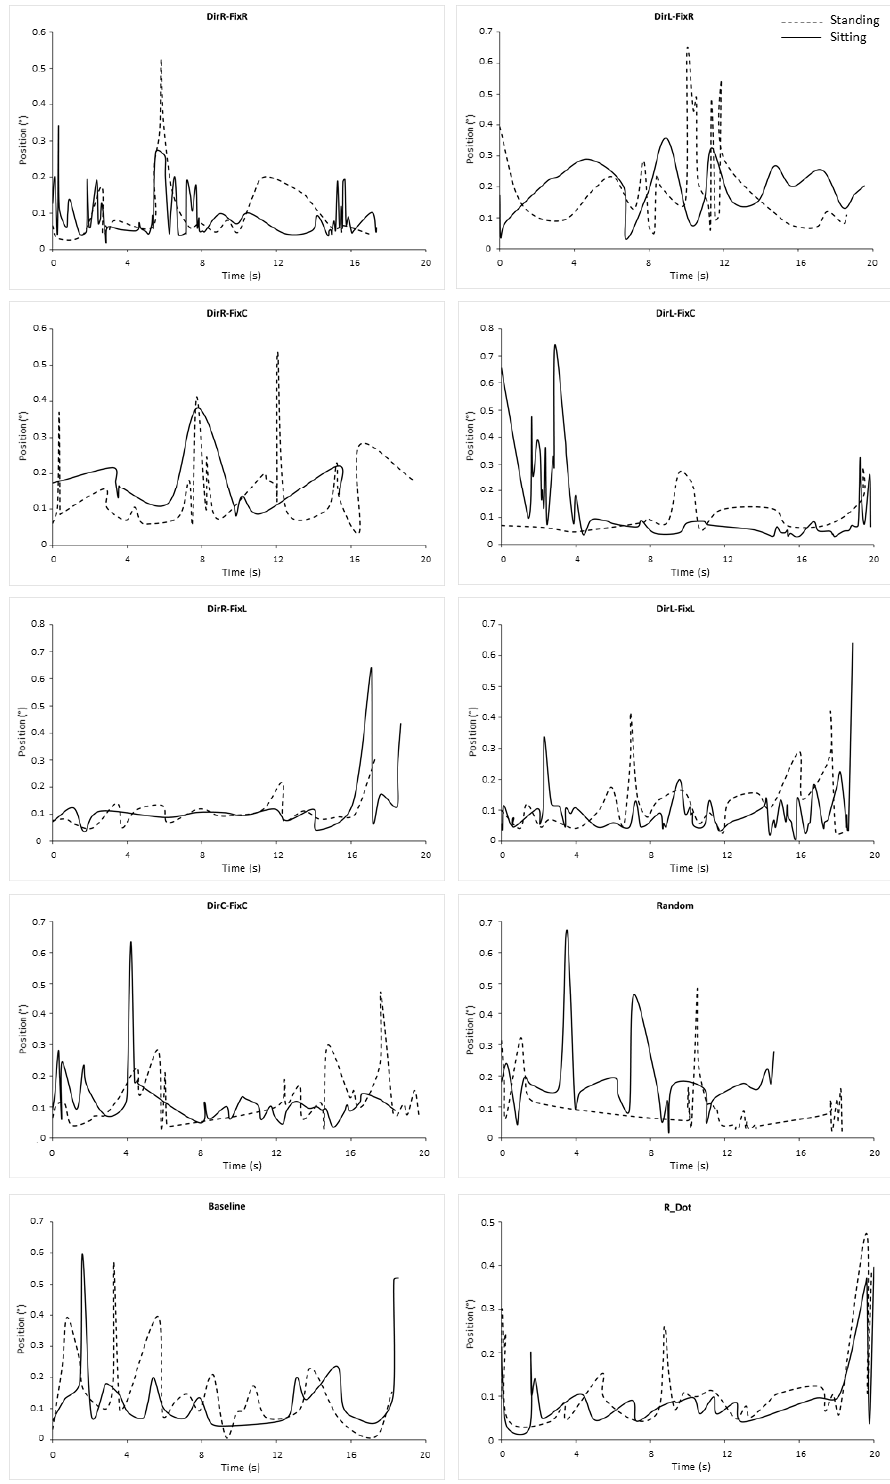
Figure 3. Waveforms of microsaccade positions in all stimuli in both conditions. Each line in each diagram represents the waveform of all microsaccades recorded in an exemplary subject and trial. DirR-FixR: subject 10, trial 1. DirL-FixR: subject 16, trial 5. DirR-FixC: subject 05, trial 3. DirL-FixC: subject 19, trial 2. Baseline: subject 03, trial 1. DirR-FixL: subject 18, trial